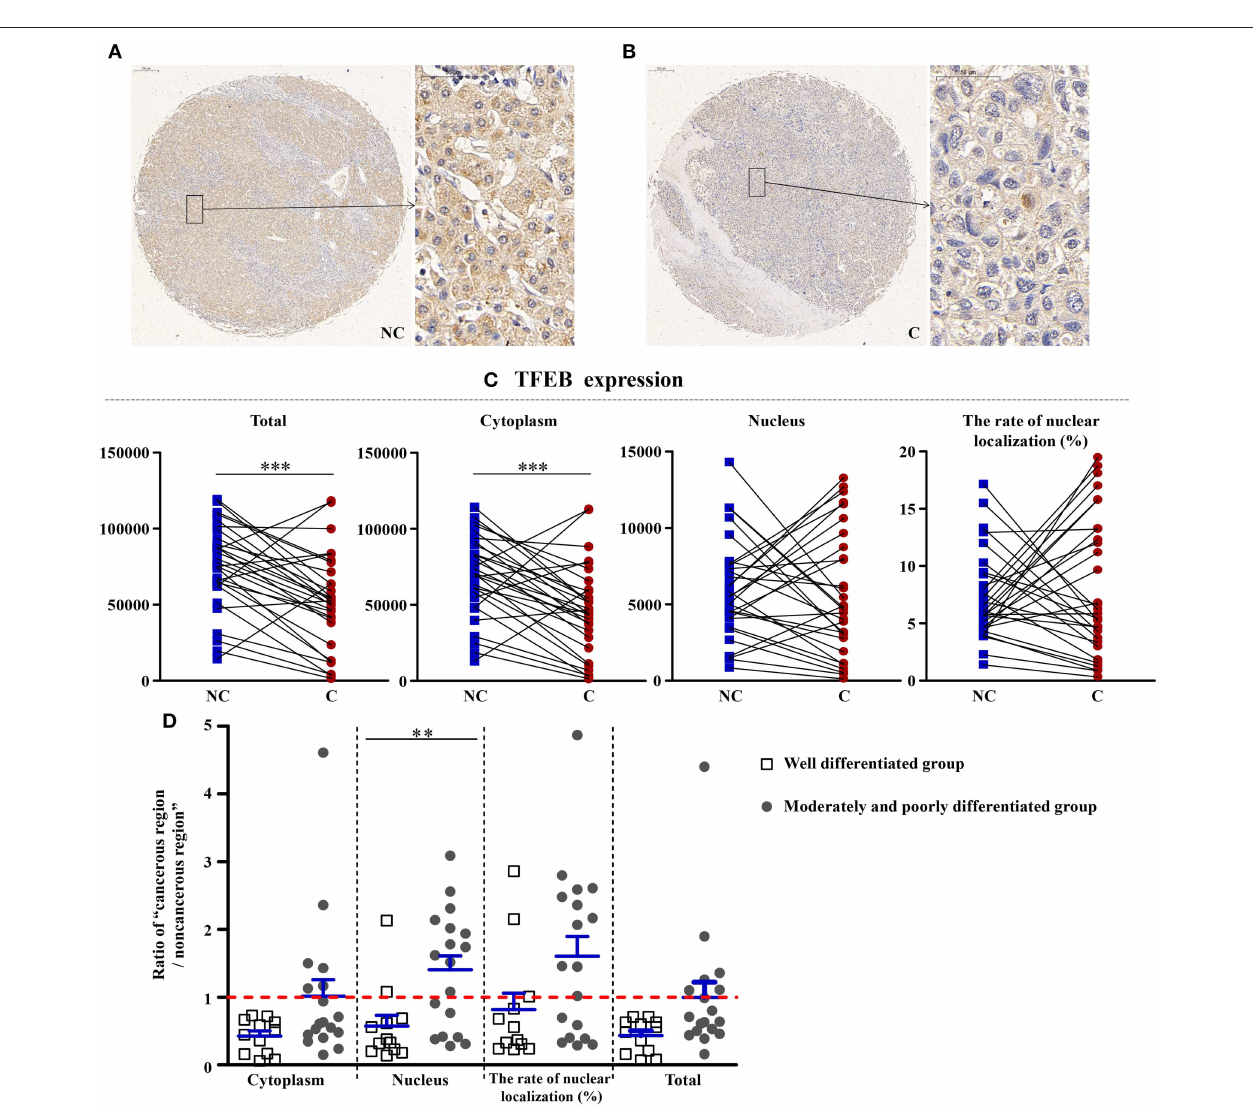
FIGURE 6 | The detailed expression of TFEB. Representative images of TFEB protein expression in liver cancer’s corresponding (A) non-cancerous (NC) and (B) cancerous (C) regions. (C) Quantification of TFEB expression (total, cytoplasmic, and nuclear expressions and the rate of nuclear localization) levels using multispectral image analysis in the liver cancer samples. (D) The ratio of “cancerous region/non-cancerous region” of TFEB expression in two groups (well-differentiated group vs. moderately and poorly differentiated group). The red line indicates that the ratio is equal to 1. Scale bar: 200 or 50 µ m. **Denotes significant differences from the well-differentiated group with P < 0.01; ***Denotes significant differences from the noncancerous region with P <